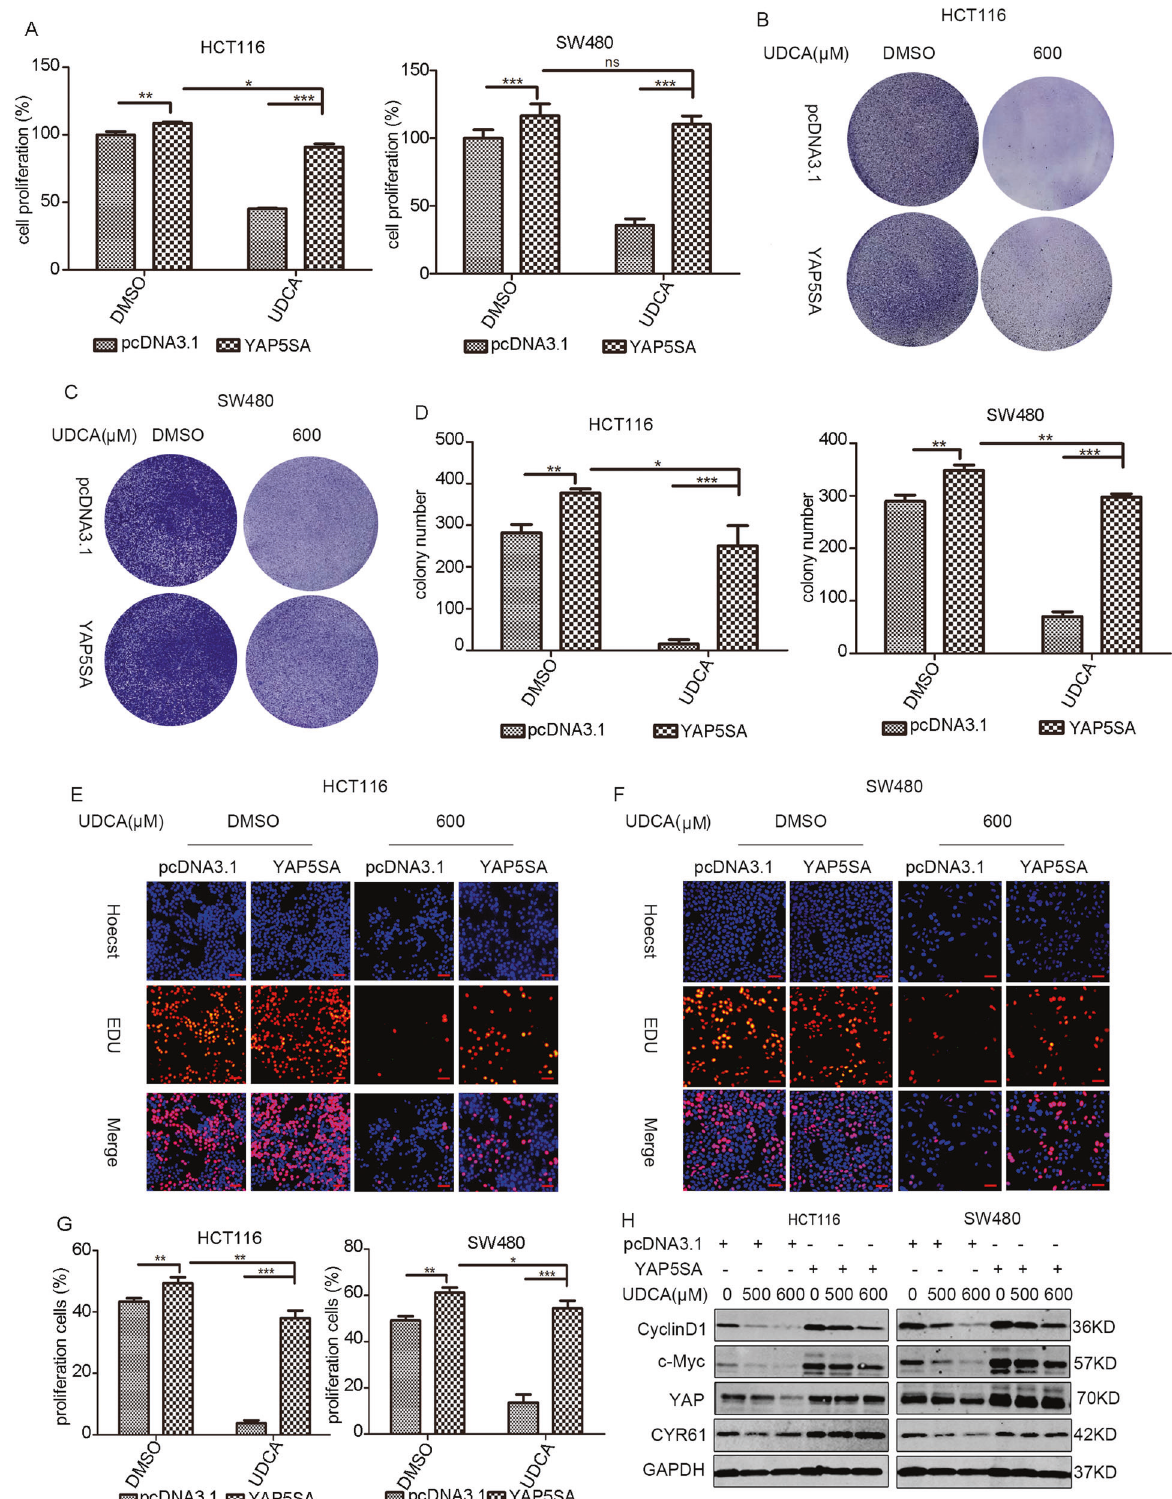
Fig. 2 UDCA regulates the survival of HCT116 cells and SW480 cells through the Hippo pathway. A MTT assay for HCT116 and SW480 cells cultured with pcDNA3.1 or YAP5SA plasmid (or/and 500 μ M or 600 μ M UDCA in HCT116 and SW480 cells, respectively) for 3 days. Data are demonstrated as the mean ± SD, * p < 0.05, ** p < 0.01, and *** p < 0.001 with Student ’ s t test (two-tailed). B – D Clonogenic assays and qualitative analysis of the HCT116 and SW480 cells cultured with pcDNA3.1 or YAP5SA plasmid (or/and 600 μ M UDCA) at day 7. EdU incorporation assay was performed to further test the cell proliferation at 72 h post-transfection in HCT116 cells ( E ) and SW480 cells ( F ). G Red labeled cells indicated the proliferated cells. The percentage of the proliferated cells was also counted. Data are demonstrated as the mean ± SD, * p < 0.05, ** p < 0.01, and *** p < 0.001 with Student ’ s t test (two-tailed). Scale bar: 25 μ m. H WB for CyclinD1, c-MYC, YAP, and CYR61 in HCT116 and SW480 cells cultured with pcDNA3.1 or YAP5SA plasmid (or/and 500 μ M or 600 μ M UDCA in HCT116 and SW480 cells, respectively) for 3 days. Cell Death Discovery (2021)